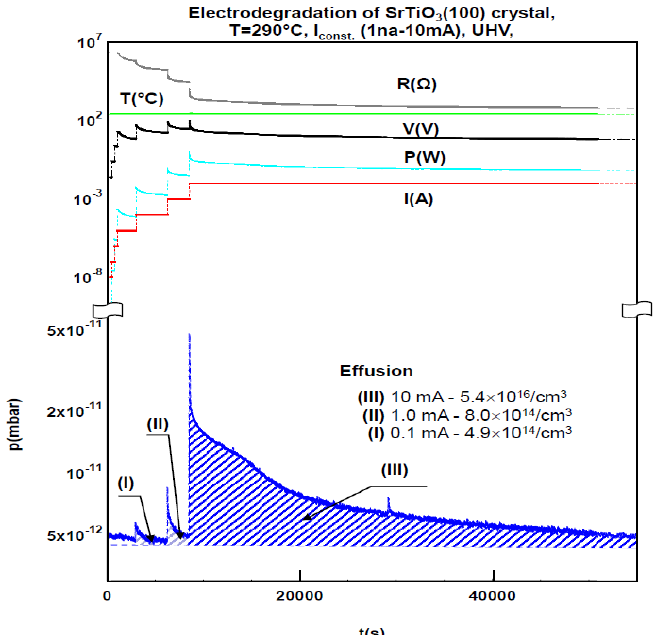
Figure 57. Study of electro-degradation (I-const.) and effusion processes shows that the decrease of the resistance of a SrTiO 3 crystal can even be observed for very low currents. A measurable effusion of oxygen from the crystal can be identified for currents as low as 0.1 mA. Yet notice, although electro-degradation with I ~ 0.1 mA already leads to a “switching” of the electrical properties of the crystal into metallic properties the total concentration of removed oxygen is still much lower than predicted from Mott criterion.